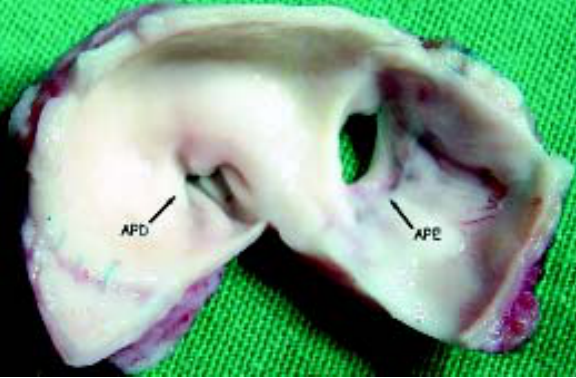
Fig. 2 – Tecido ressecado da origem das artérias pulmonares. APD: artéria pulmonar direita, APE: artéria pulmonar esquerda